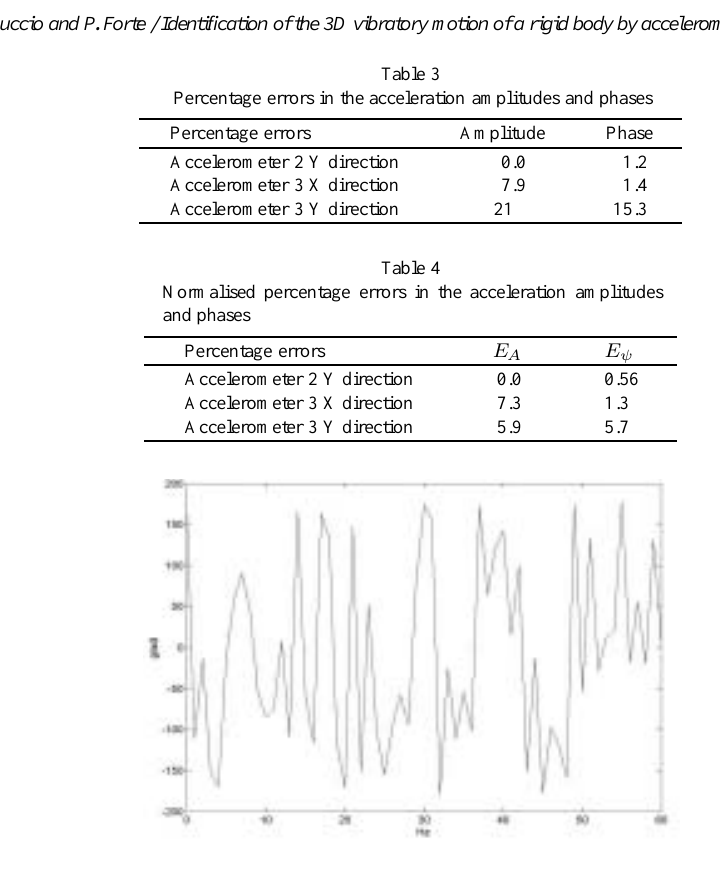
Fig. 9. Phase spectrum of acceleration in the X direction measured by accelerometer 1 ( ◦